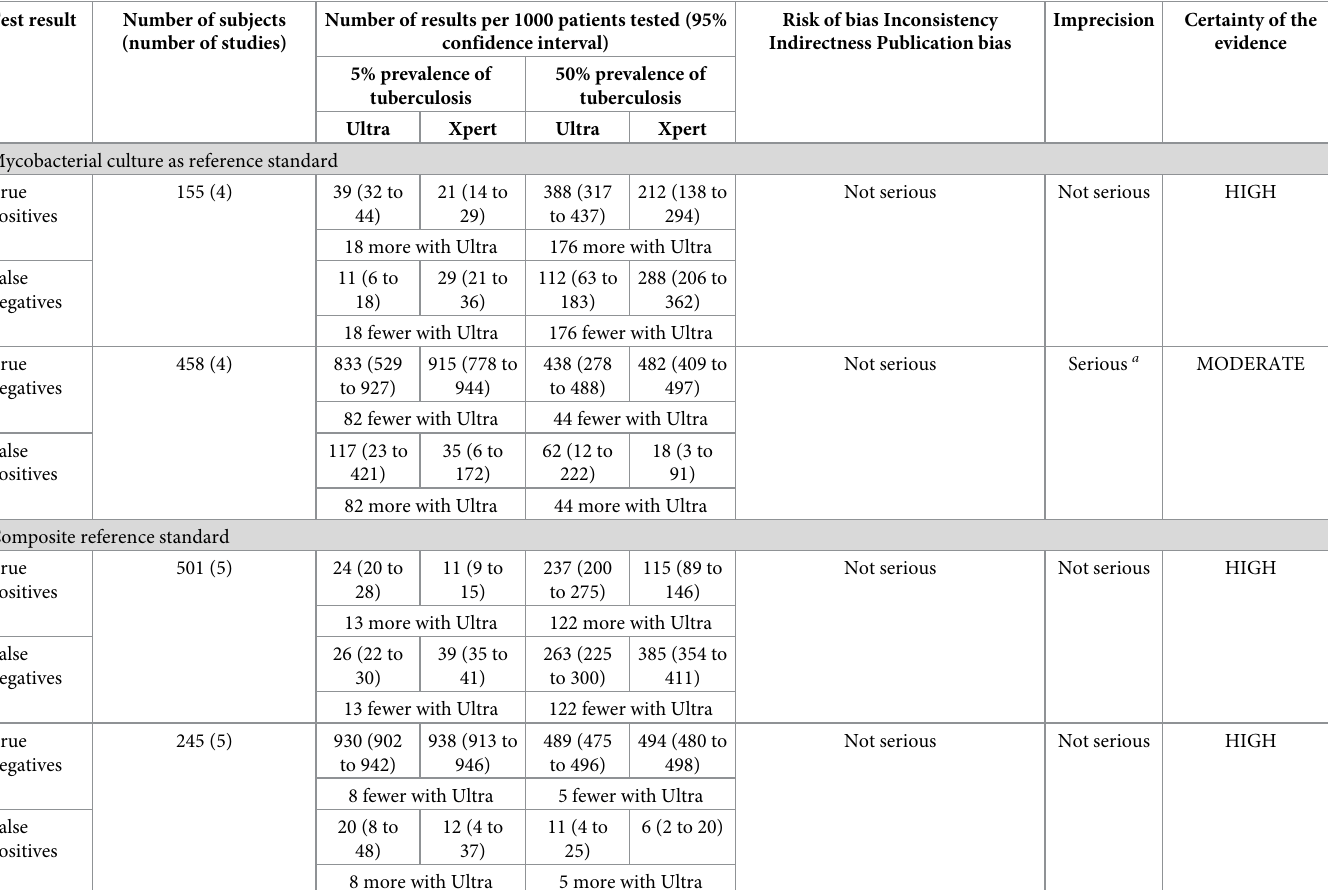
Table 2. Summary of findings from studies comparing both pleural fluid Xpert and Ultra assays for diagnosing tuberculous pleural effusion in the same patient population. Test